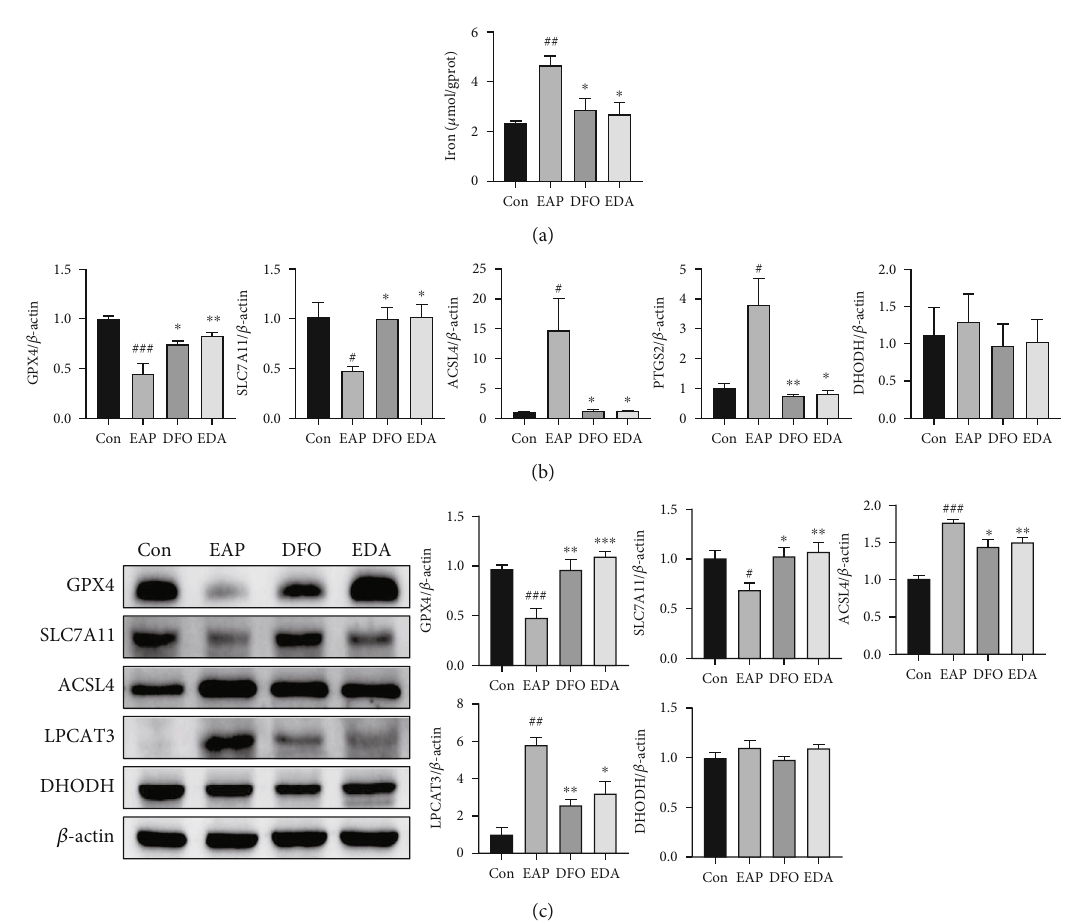
Figure 4: DFO and EDA attenuated ferroptosis in EAP model. (a) The iron concentration of prostate lysates was determined by the commercial kit. Results were normalized to protein concentration. (b) The mRNA levels of ferroptosis biomarkers GPX4, SLC7A11, ACSL4, PTGS2, and DHODH relative to internal control were determined by the RT-PCR method. (c) The protein levels of ferroptosis biomarkers GPX4, SLC7A11, ACSL4, LPCAT3, and DHODH were determined by the western blot method. The relative quanti fi cation result of each band was performed relative to β -actin. Data was presented as mean ± SEM . # P < 0 : 05 versus the control group; ## P < 0 : 01 versus the control group; ### P < 0 : 001 versus the control group; ∗ P < 0 : 05 versus the EAP group; ∗∗ P < 0 : 01 versus the EAP group; ∗∗∗ P < 0 : 001 versus the EAP